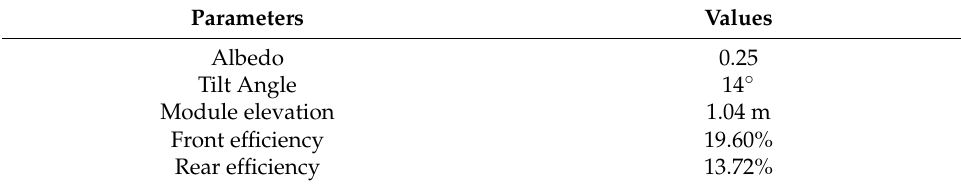
Table 2. System parameters.